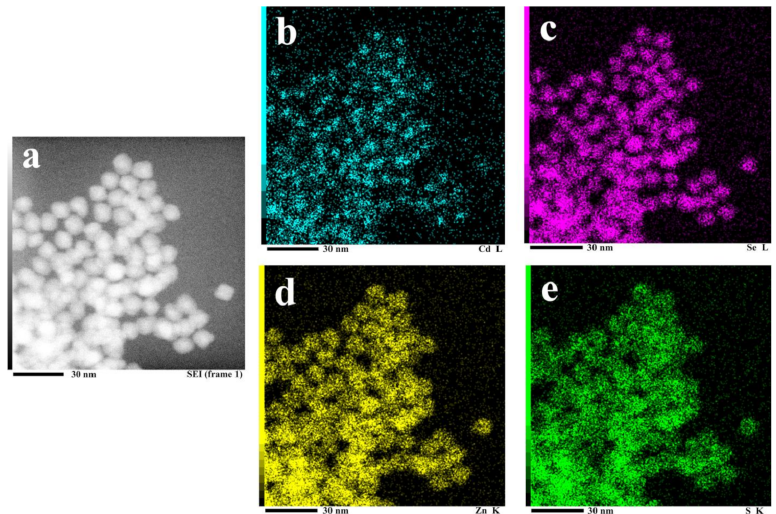
Figure 3. ( a ) The SEI image of CdZnSeS-pATP QDs. ( b – e ) EDS elemental mappings of Cd ( b ), Se ( c ), Zn ( d ) and S ( e ) corresponding to the CdZnSeS-pATP QDs array in Figure 3a. CdZnSeS-pATP QDs were prepared through OA in CdZnSeS-OA QDs exchanged by pATP. The surface ligand modification belongs to an X-type exchange in which both attacking and leaving ligands are negative-donors coordinating cationic-acceptors such as Zn atoms on surfaces of CdZnSeS QDs [25]. Apart from the fact that the bond energy of PhS-Zn in CdZnSeS-pATP is stronger than RCOO-Zn in CdZnSeS-OA [17], the removal of OA ligand by washing with the solvent ethanol also promotes the exchange [25]. Figure S1 shows the UV absorption spectra of the ethanol eluent of CdZnSeS-OA QDs after being treated by pATP. The UV absorption peak at 212 and 253 nm are assigned to the K band and B band of pATP respectively, and the two bands are derived from π – π * transition of the conjugated substituted benzene structure of pATP [26]. The UV absorption spectra indicate that both peaks at 212 and 253 nm gradually reduce with washing times of ethanol, and the absorbance spectrum for the seventh ethanol eluent is almost the same as that of ethanol [27], indicating that pATP physically absorbed on surfaces of CdZnSeS-pATP QDs could be removed through ethanol washing. The UV spectrum for the residue of the pATP treated CdZnSeS-OA after ethanol washing, CdZnSeS-OA and pATP, are shown in Figure S2. It clearly indicates that the UV spectra of the residue of the pATP treated CdZnSeS-OA after ethanol washing is very similar to that of pATP, implying that CdZnSeS- pATP QDs could be obtained through the ligand exchange